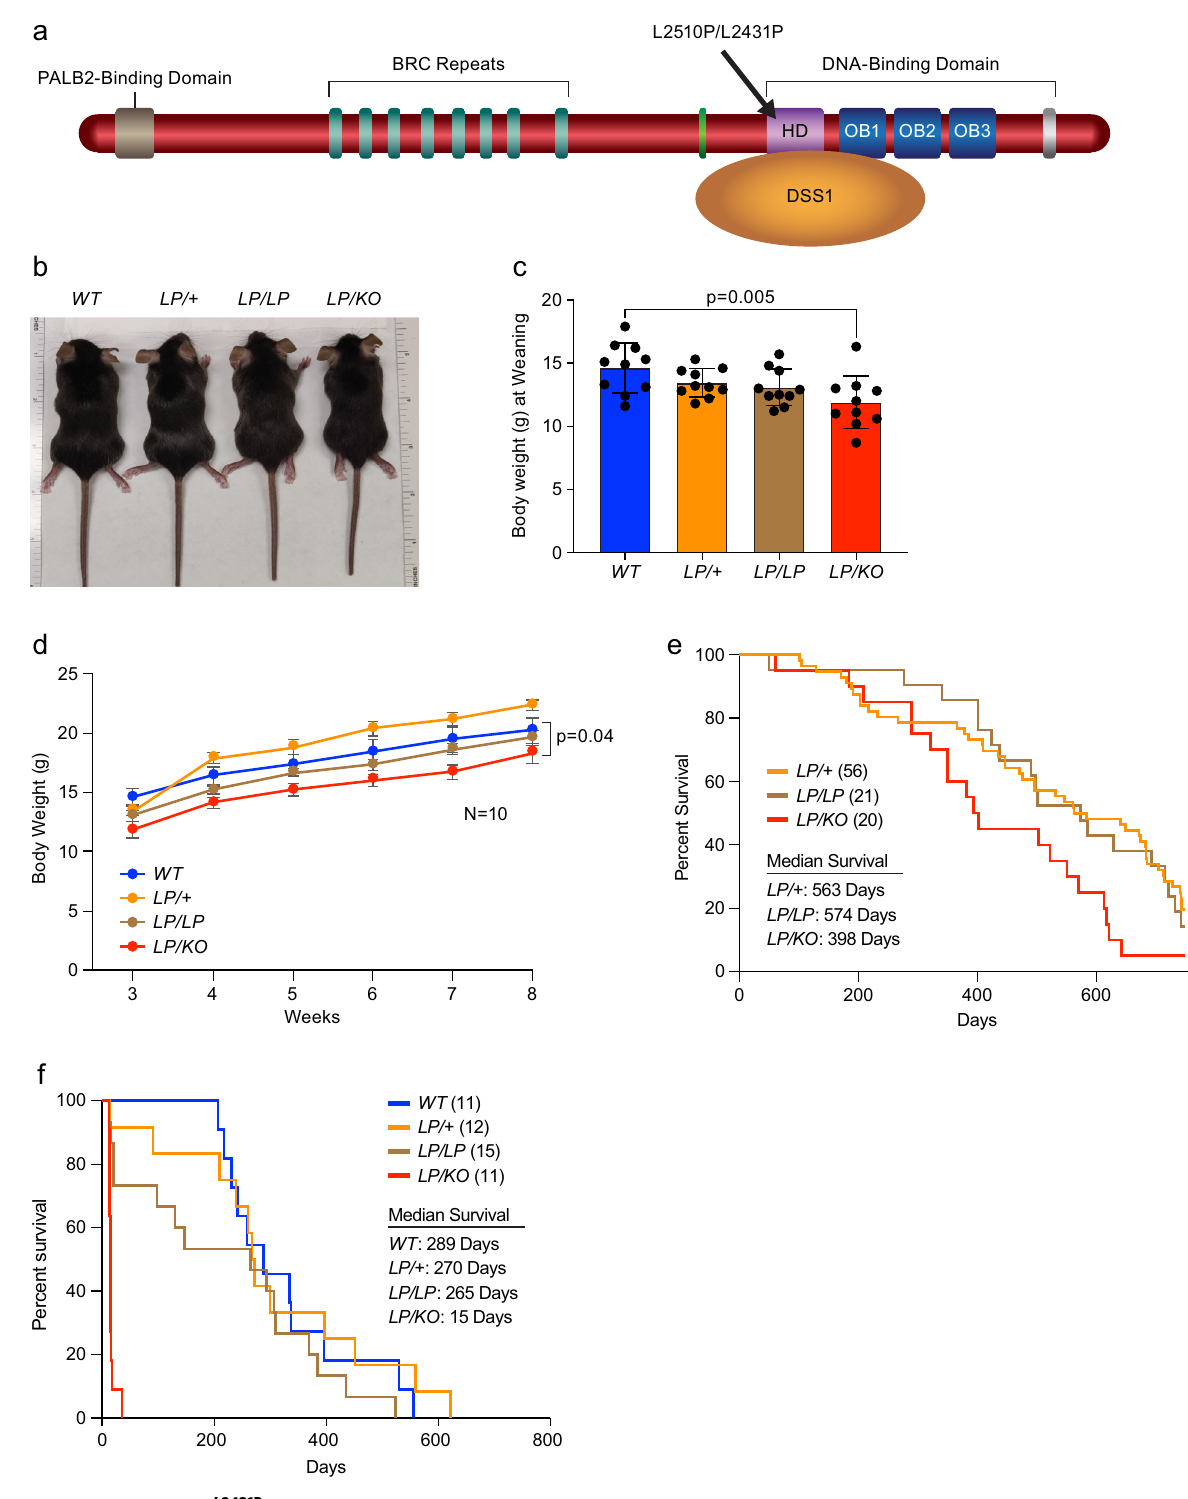
Fig. 1 Physiology of Brca2 L2431P homozygous and hemizygous mice. a Schematic representation of BRCA2 protein showing different functional domains: N-terminal PALB2 binding domain, eight BRC repeats in the middle and a C-terminal DNA binding domain consisting of a helical domain (HD) and three oligo-binding (OB) domains. BRCA2 L2520P/L2431P variant is in the HD and disrupts interaction with DSS1. b Representative images of mice of indicated genotypes at weaning (21 days). c Body weights of mice at weaning showing signi fi cantly reduced body weight of LP/KO mice compared to WT mice ( n = 10, two-tailed Student ’ s t test, error bar- SD of mean). d Body weights of mice of indicated genotypes measured for 8 weeks post-weaning, LP/KO mice weighed less compared to the WT littermates ( n = 10, one-tailed t -test: two-sample assuming unequal variances, error bar- SE of mean). e Kaplan – Meier survival curve for 800 days of mice of indicated genotypes. LP/KO mice have reduced median survival ( p = 0.009, Log-rank Mantel-Cox test) compared to LP/ + and LP/LP . f Kaplan – Meier survival curve of mice of different genotypes after 8 Gy of γ -radiation, LP/KO mice showed median survival of 15 days and are extremely sensitive to radiation as compared to all other genotypes ( p = 0.0001, Log-rank Mantel – Cox